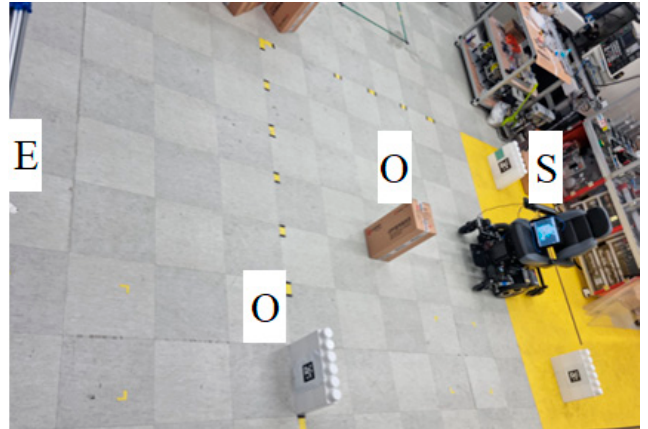
Figure 16. Experiment for autonomous driving on the path (S: start point, O: obstacle, and E: end point).